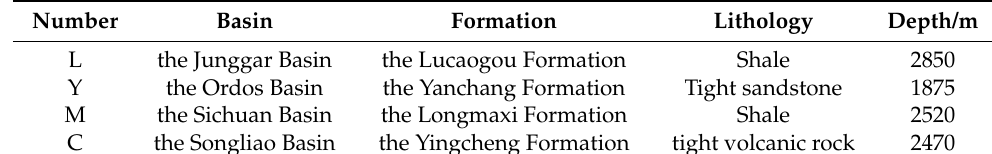
Table 1. Sampling number and the formation information.